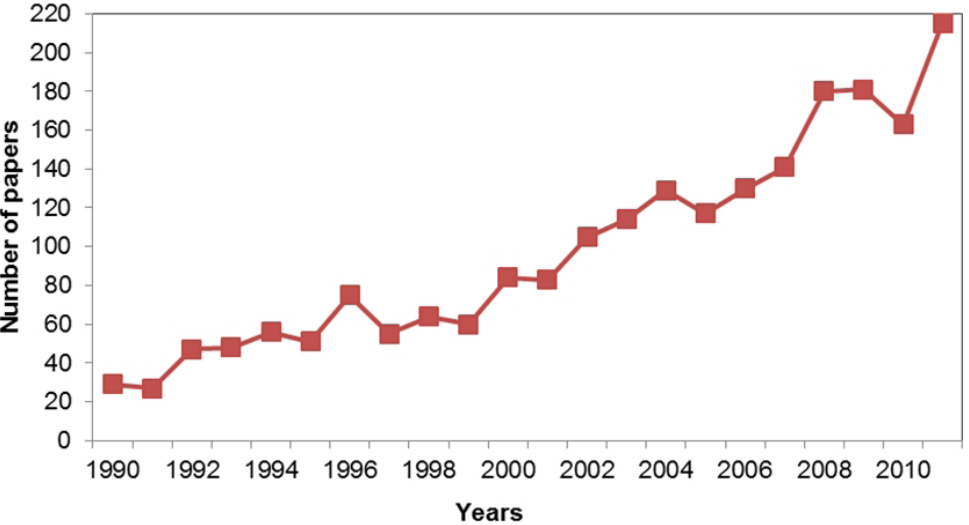
Figure 5. The number of reviewed articles containing negative keywords, published between 1990 and